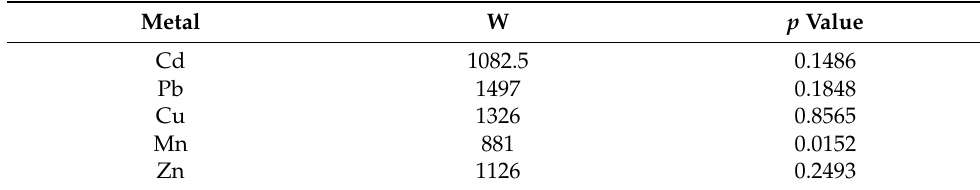
Table 2. Mann–Whitney U test for heavy metal concentrations in Parmotrema arnoldii and Tillandsia usneoides .